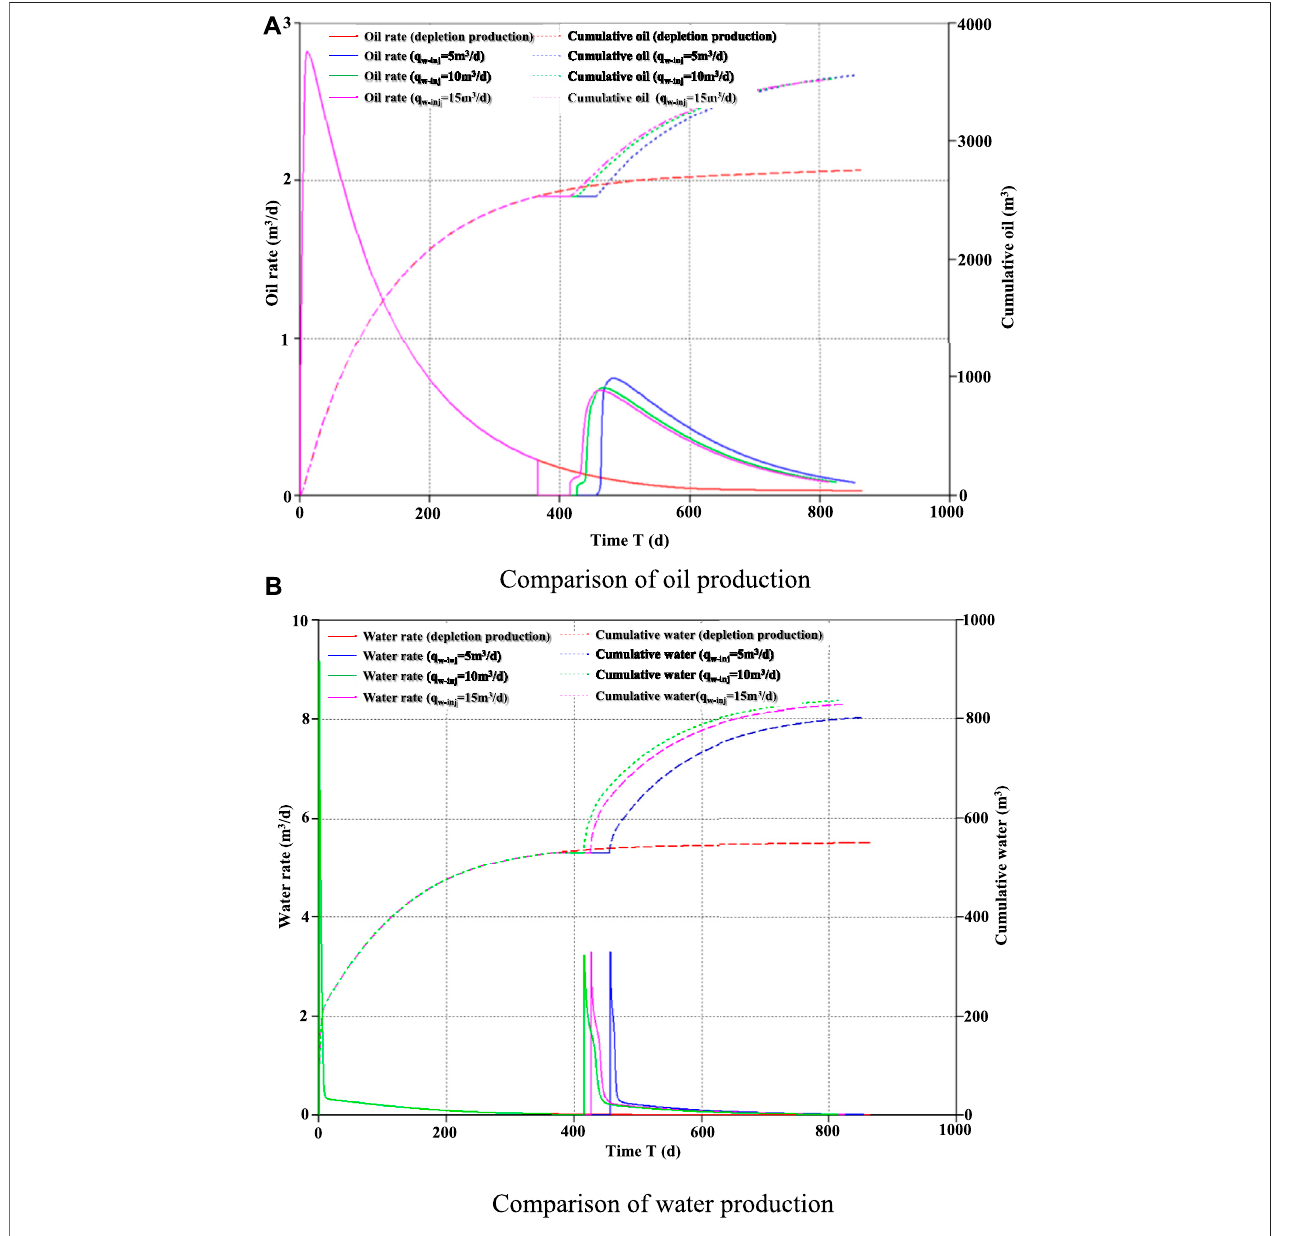
FIGURE 10 | Comparison of oil and water production with different injection rates. (A) Comparison of oil production. (B) Comparison of water production.